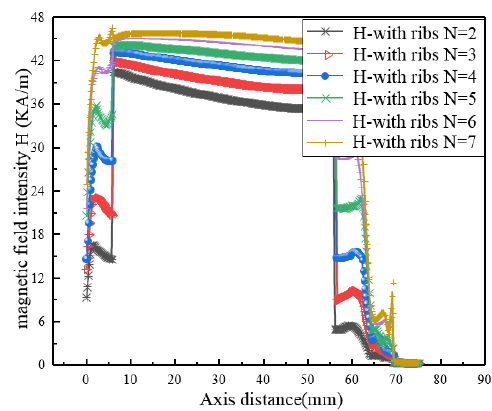
Figure 11. H of different magnetic circuits.